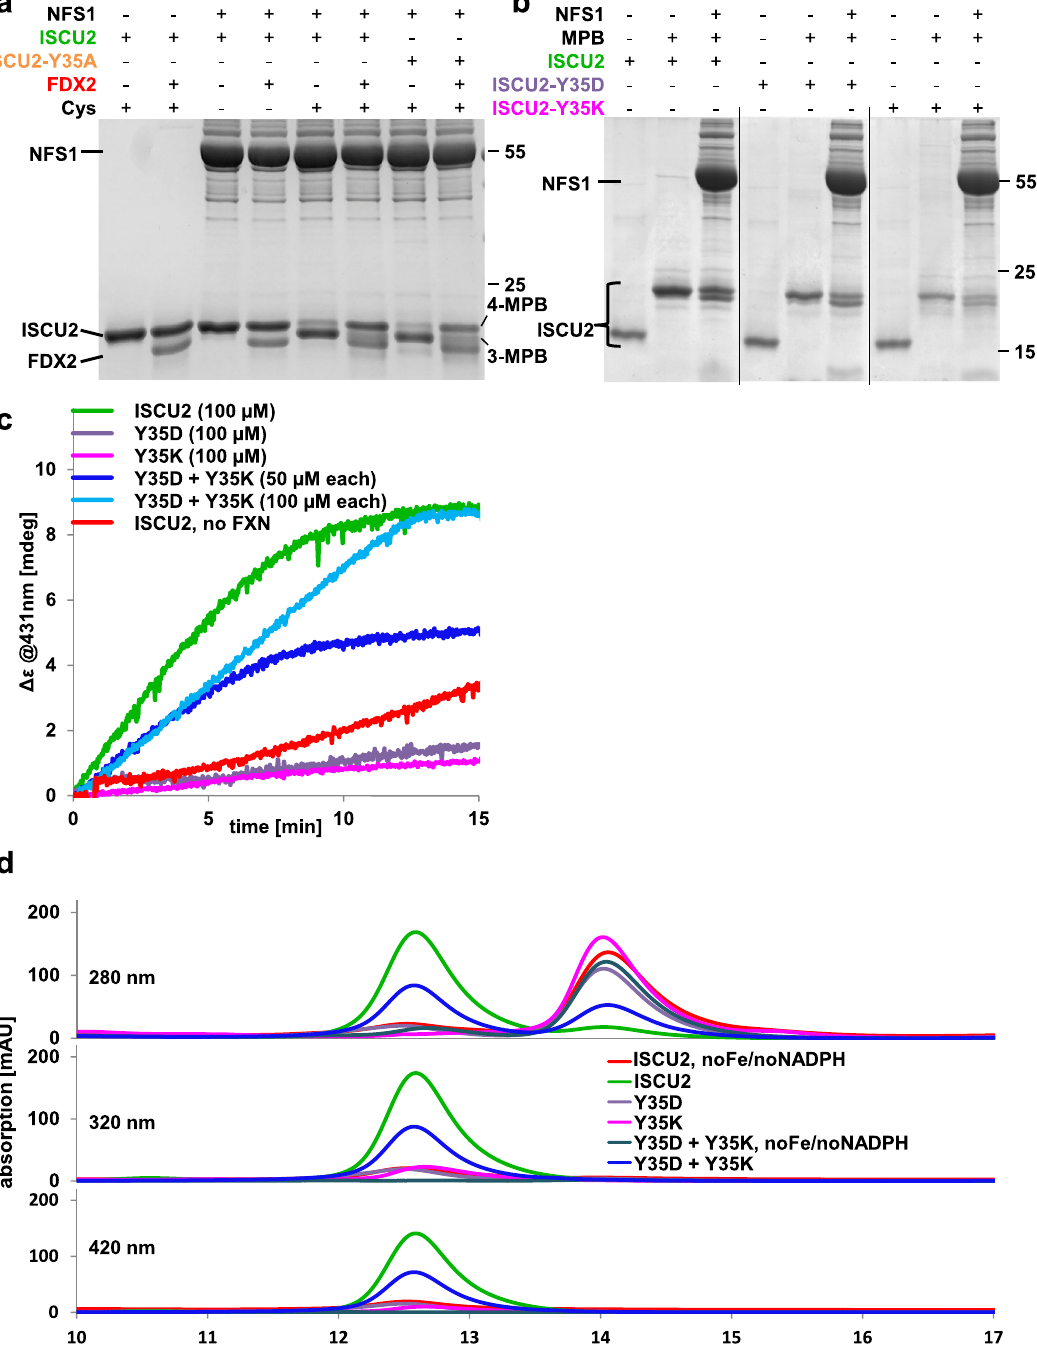
NATURE COMMUNICATIONS| (2021) 12:6902